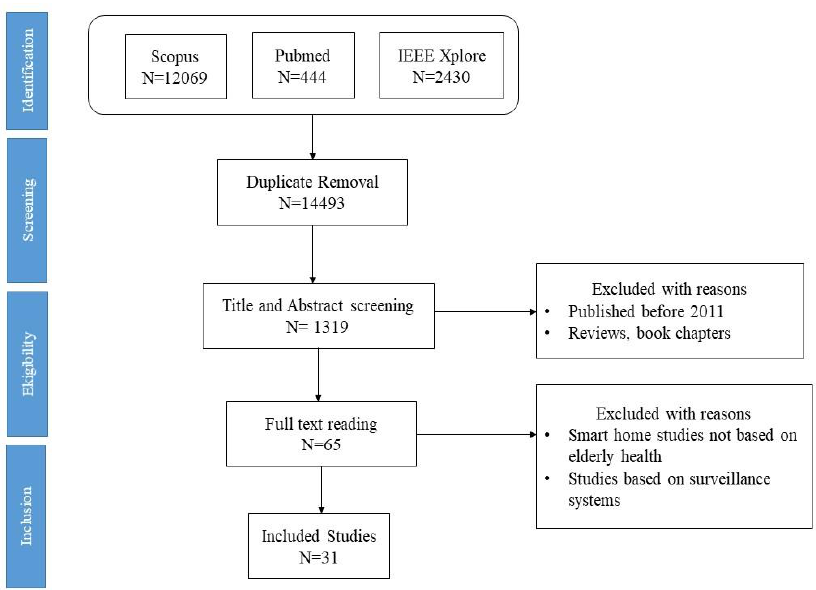
Figure 1. Schematic illustration of the literature search.